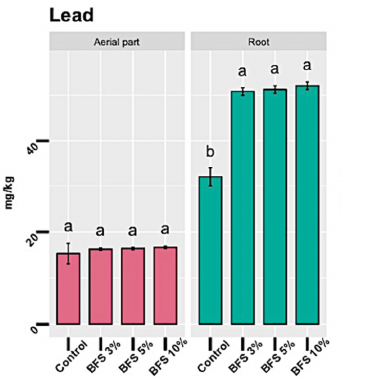
Figure 6. PTE content in roots and aerial parts in plants with Blast Furnace Slag (BFS).